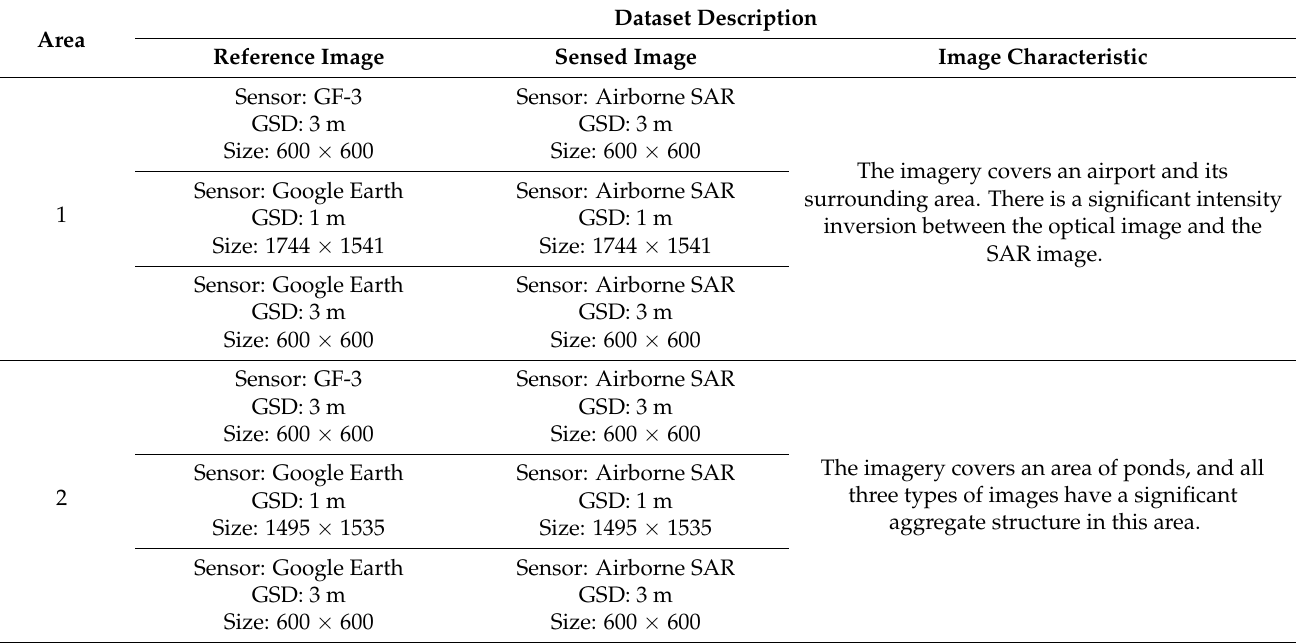
Table 1. Image pairs with Nonlinear intensity